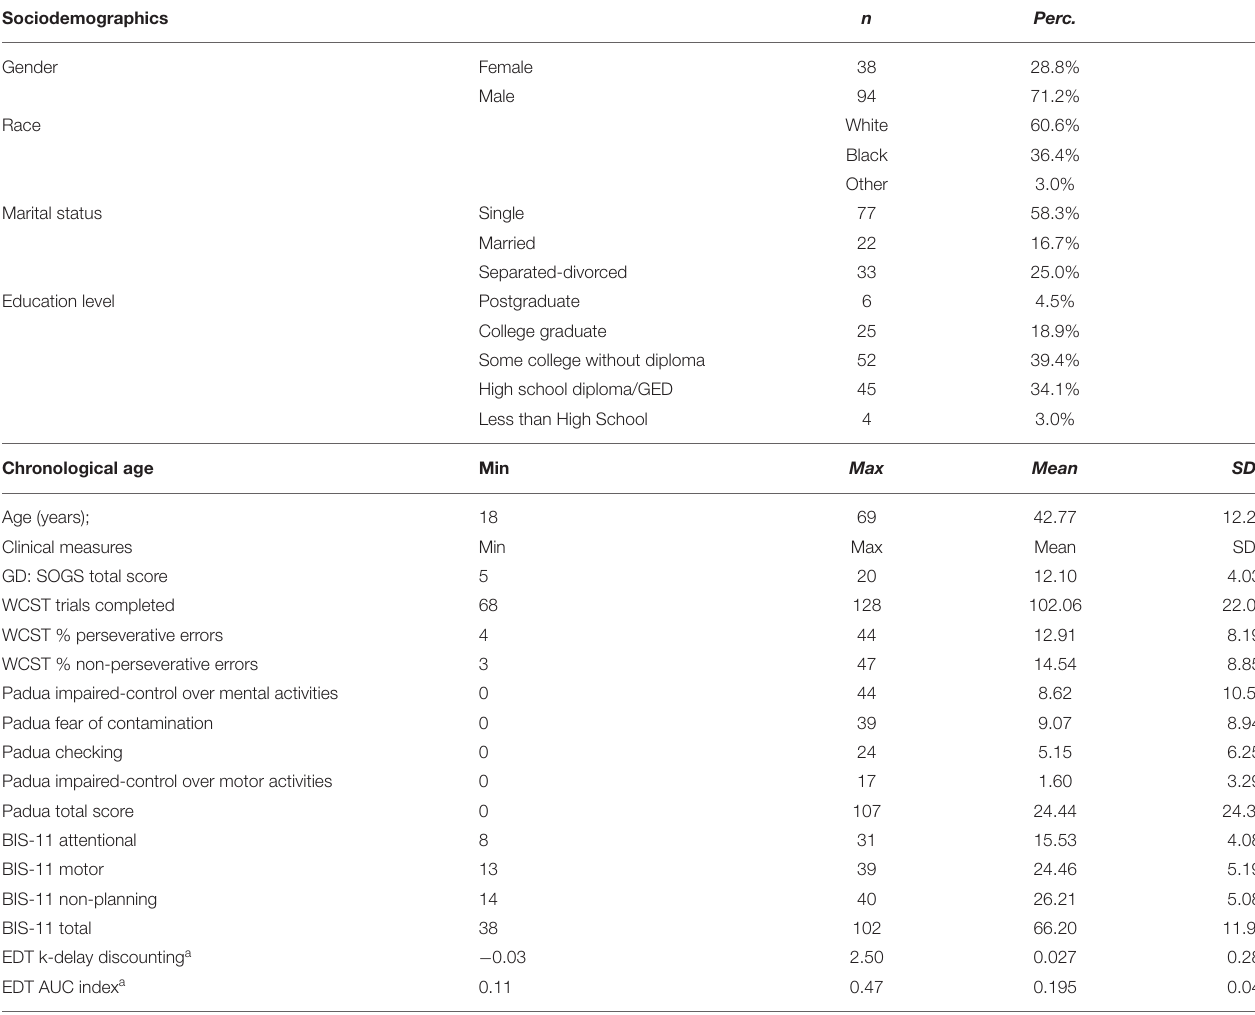
TABLE 1 | Sample description ( N = 132).